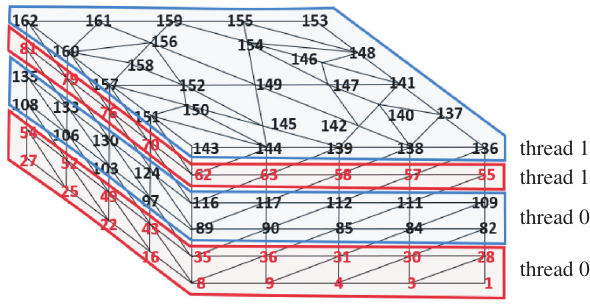
Figure 10. Semi-structured mesh for the 3-D simulation and its